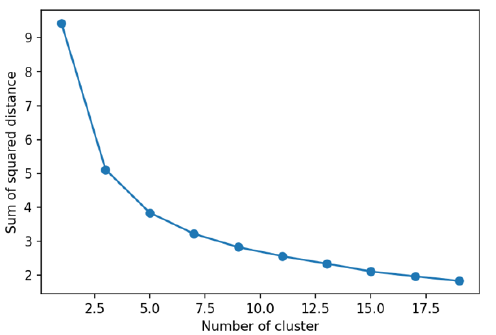
Figure 5. The elbow method is used to determine the number of clusters [41,42].